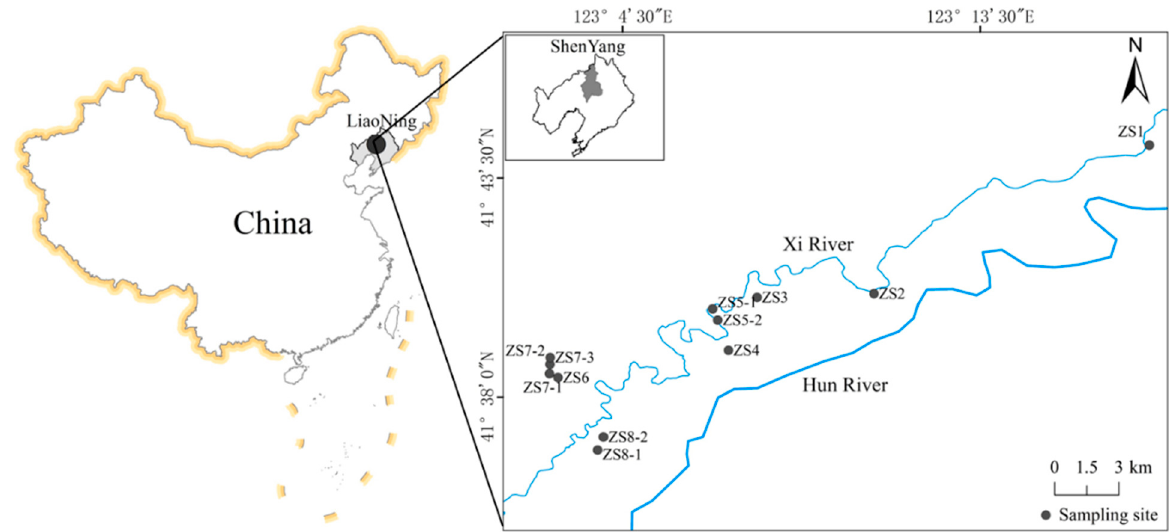
Figure 1. Geographical locations of the sampling sites in the study area.